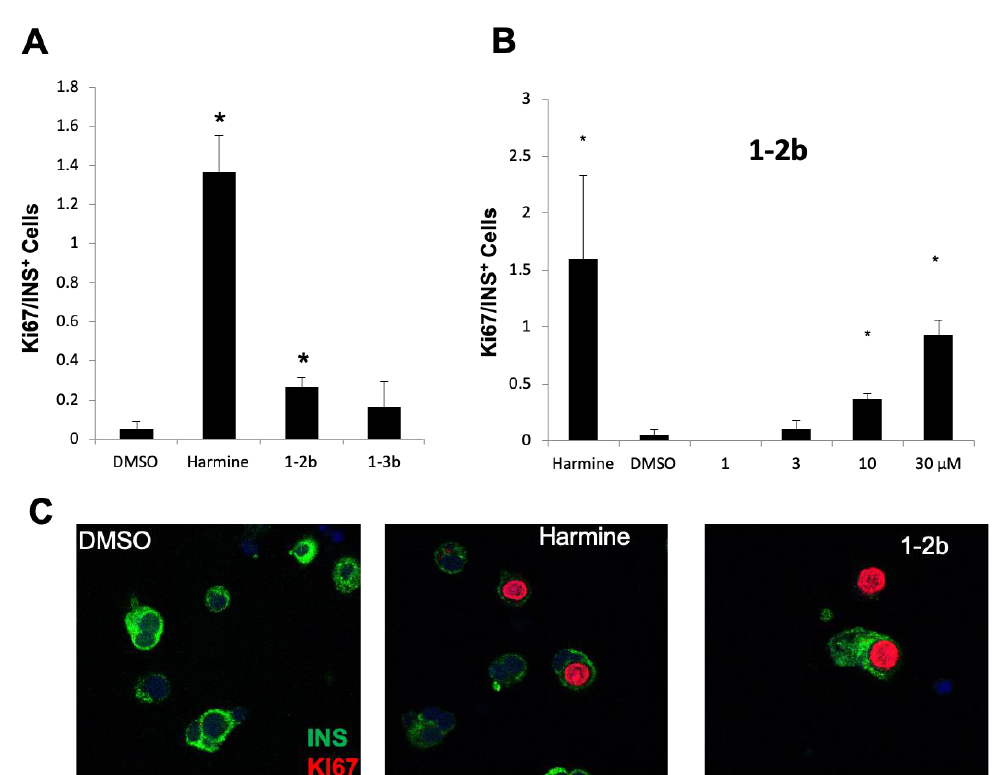
Figure 4. Effects of harmine analogues on human β-cell proliferation. ( A ) Initial screening of harmine analogues on human β-cell proliferation at 10 μM. DMSO was used as a negative control, and harmine was used as a positive control ( n = 3). ( B ) Dose–response curves for human β-cell proliferation for 1-2b in human β-cells ( n = 3 human islet donors for each dose; harmine (10 μM) is the positive control. ( C ) A representative example from ( B ) of Ki67-insulin double-positive cells induced by 1-2b and harmine. Error bars indicate SEM and * indicates p < 0.05. A minimum of 1000 β-cells was counted for each graph. In all relevant panels, error bars indicate SEM and, * indicates p < 0.05. A minimum of 1000 β-cells was counted for each graph.